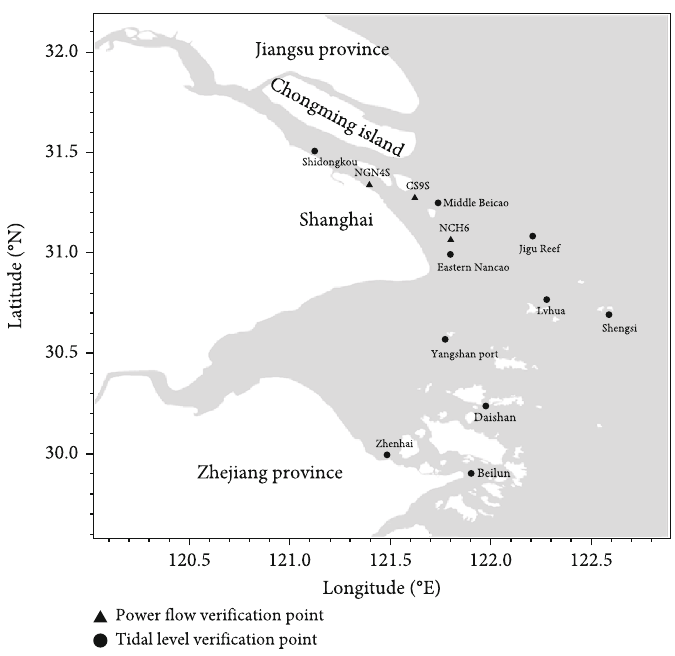
Figure 4: Diagram of veri fi cation